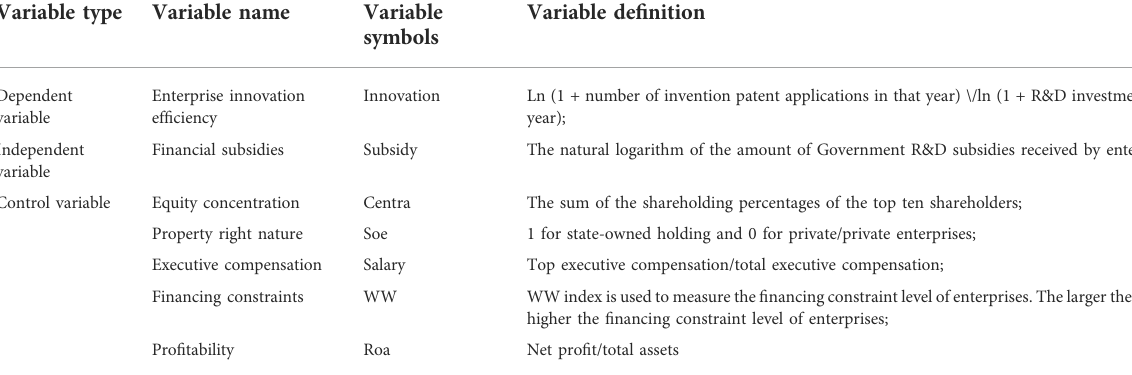
TABLE 2 Summary of de fi nitions and measures of main variables.